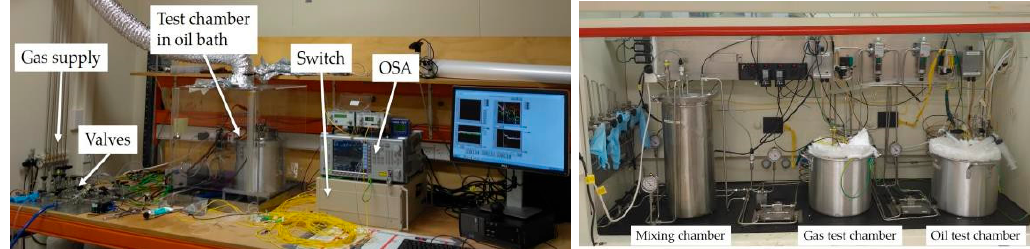
Figure 2. Experimental setups to measure the sensor response in hydrogen gas mixtures ( left ) and dissolved hydrogen in oil mixtures (r ight ).